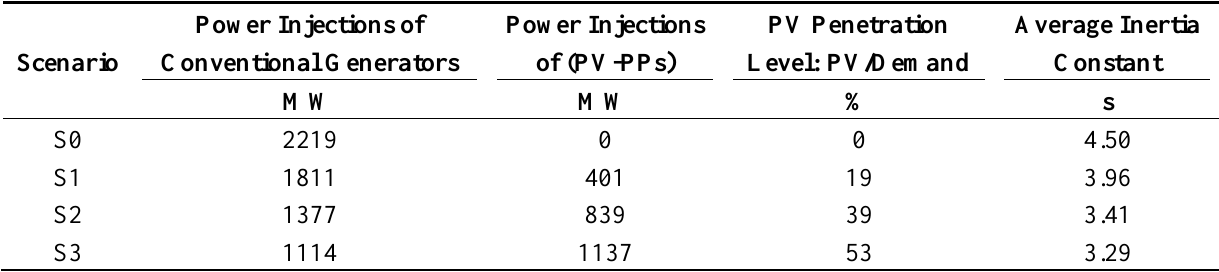
Table 1. Characteristics of the Scenarios.